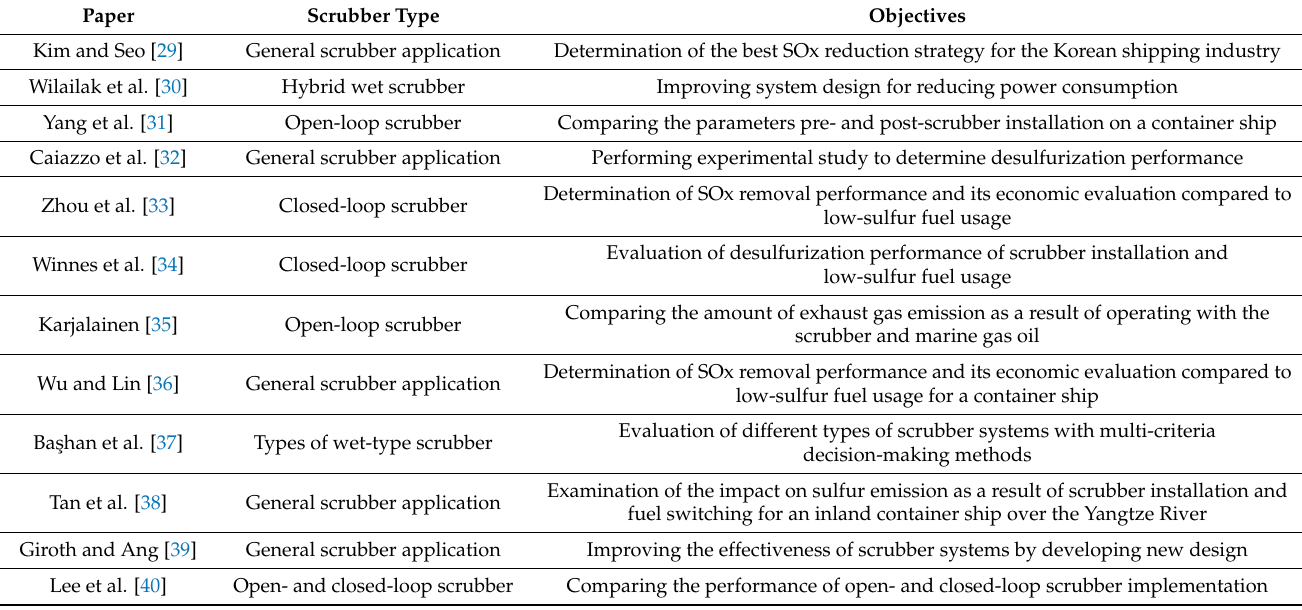
Table 1. The summary of the papers regarding scrubber installation to